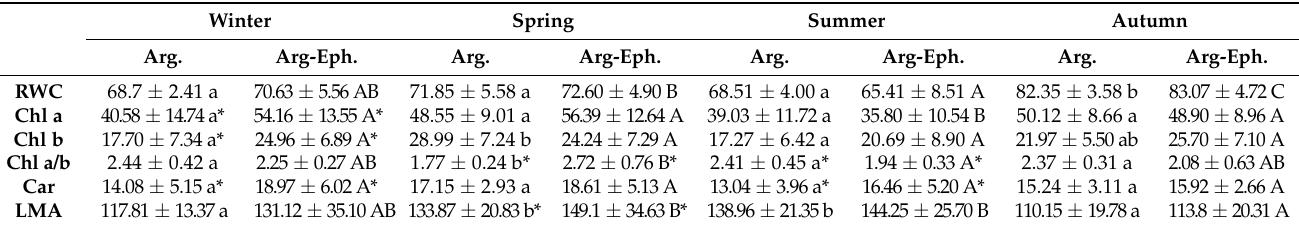
Table 2. Leaves attributes mean values ( ± SD) of the Argan trees with (Arg-Eph.) and without the liana (Arg.) throughout the study period. The asterisks show significance levels when comparing the two sites within each season by students’ t -tests (* p < 0.05). Lower-case and upper-case indicate Post-hoc test